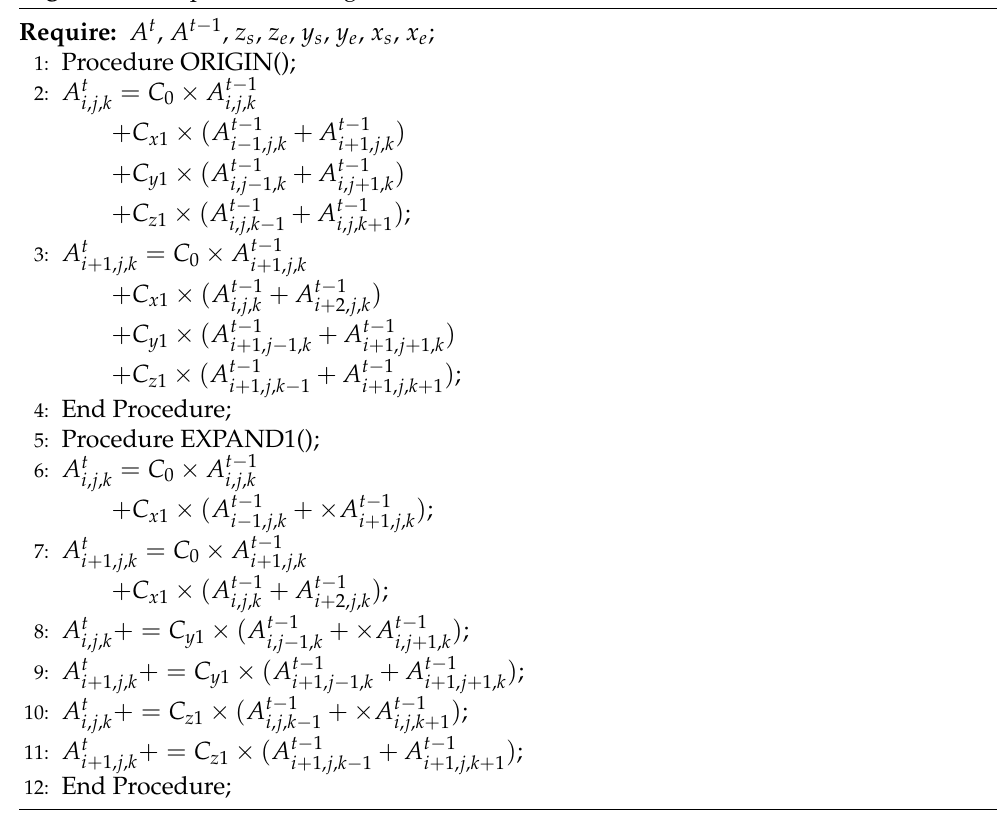
Algorithm 7 Expand the 2 original iteration